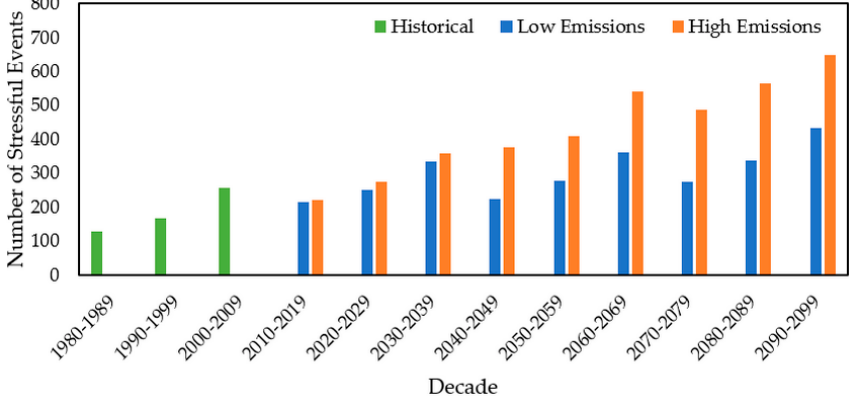
Figure 14. Number of stressful events predicted in the Cork Brook watershed between 1980 and 2099 under historical conditions, low CO 2 emissions and high CO 2 emission scenarios.